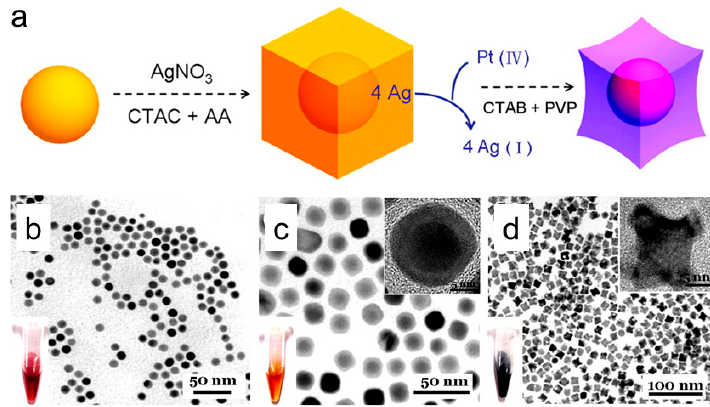
Figure 7. Schematic illustrations of ( a ) the formation of the concave Au@Pt nanocubes and TEM images and colloidal solutions (inset) of ( b ) Au NPs, ( c ) Au@Ag nanocubes, and ( d ) concave Au@Pt nanocubes. Reproduced with permission from ref. [92]. Copyright 2013 American Chemical Society.